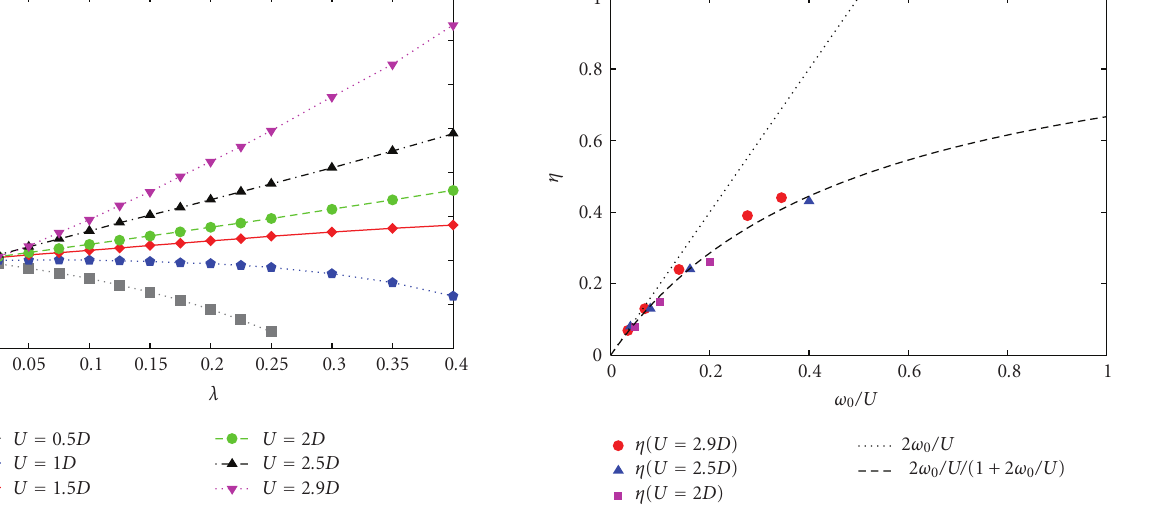
Figure 4: E ff ect of the electron-phonon interaction on the quasi- particle weight z in the presence of electron-electron interaction of di ff erent strengths. The quantity plotted as a function of λ is the ratio between the full z and the value of the Hubbard model without e-ph coupling ( z (0)) (after Sangiovanni et al. [45]).